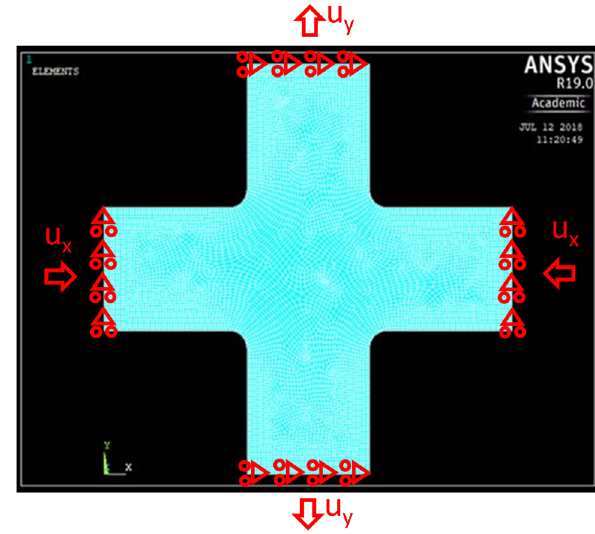
Figure 11: Finite element mesh of the model.